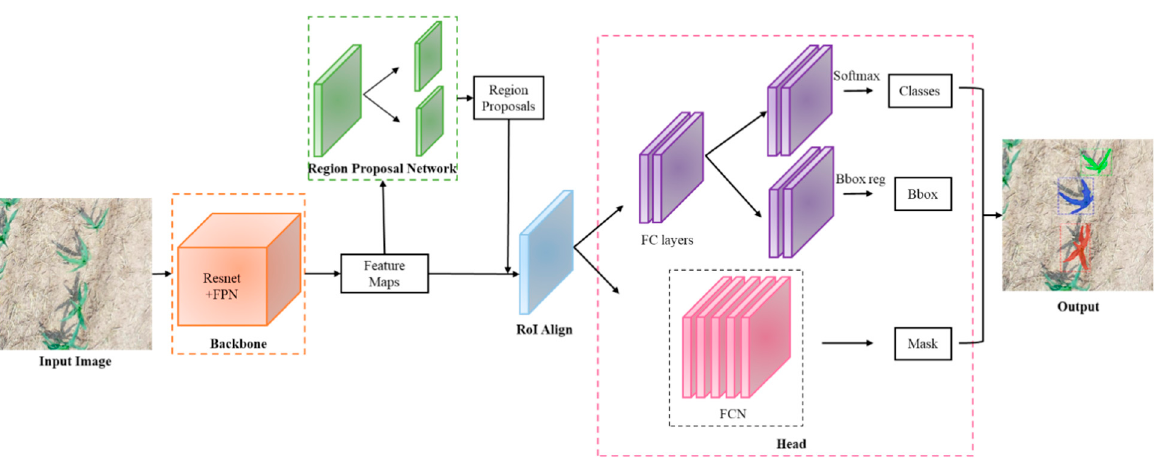
Figure 3. Mask R-CNN structure.